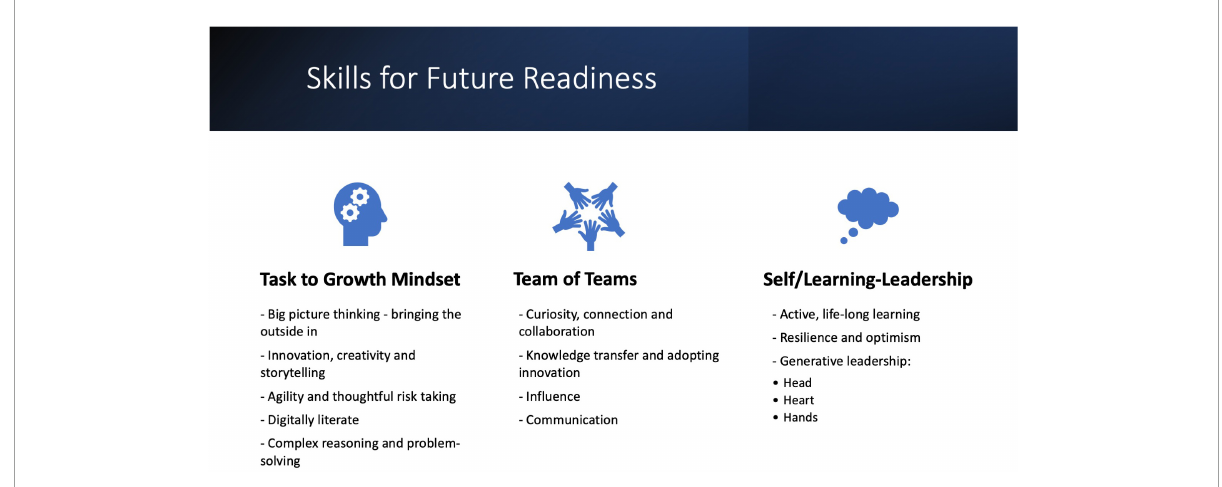
FIGURE2 Skills required for future readiness for regulatory affairs